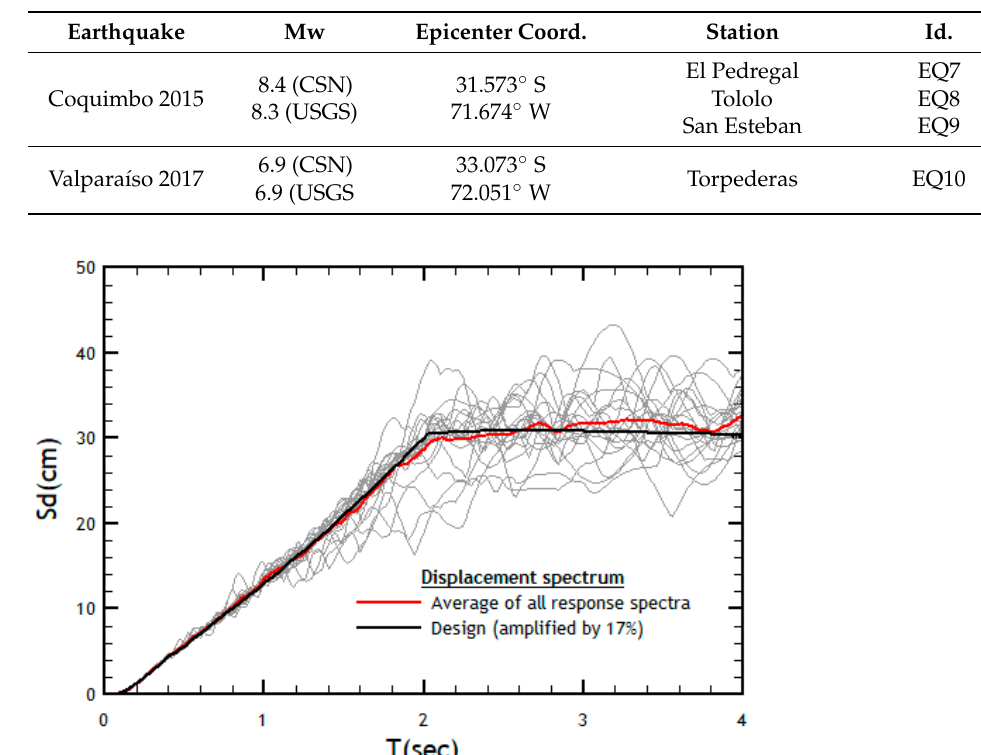
Figure 9. Response spectra of the two components of all the considered records matched with the displacement design spectrum (the same in the two directions) amplified by 17%. Table 4. Suite of 10 ground motions consistent with the Chilean response spectra in Figure 8.